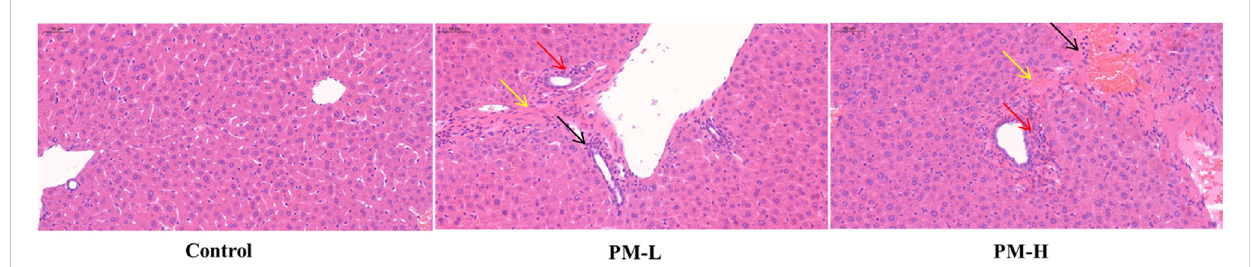
FIGURE 4 Liverhistology(H&Estain,200x,Scalebar=50 µm)ofmice;Hepatocytenecrosisanddissolution,replacedbyhyperplasticconnectivetissue(yellow